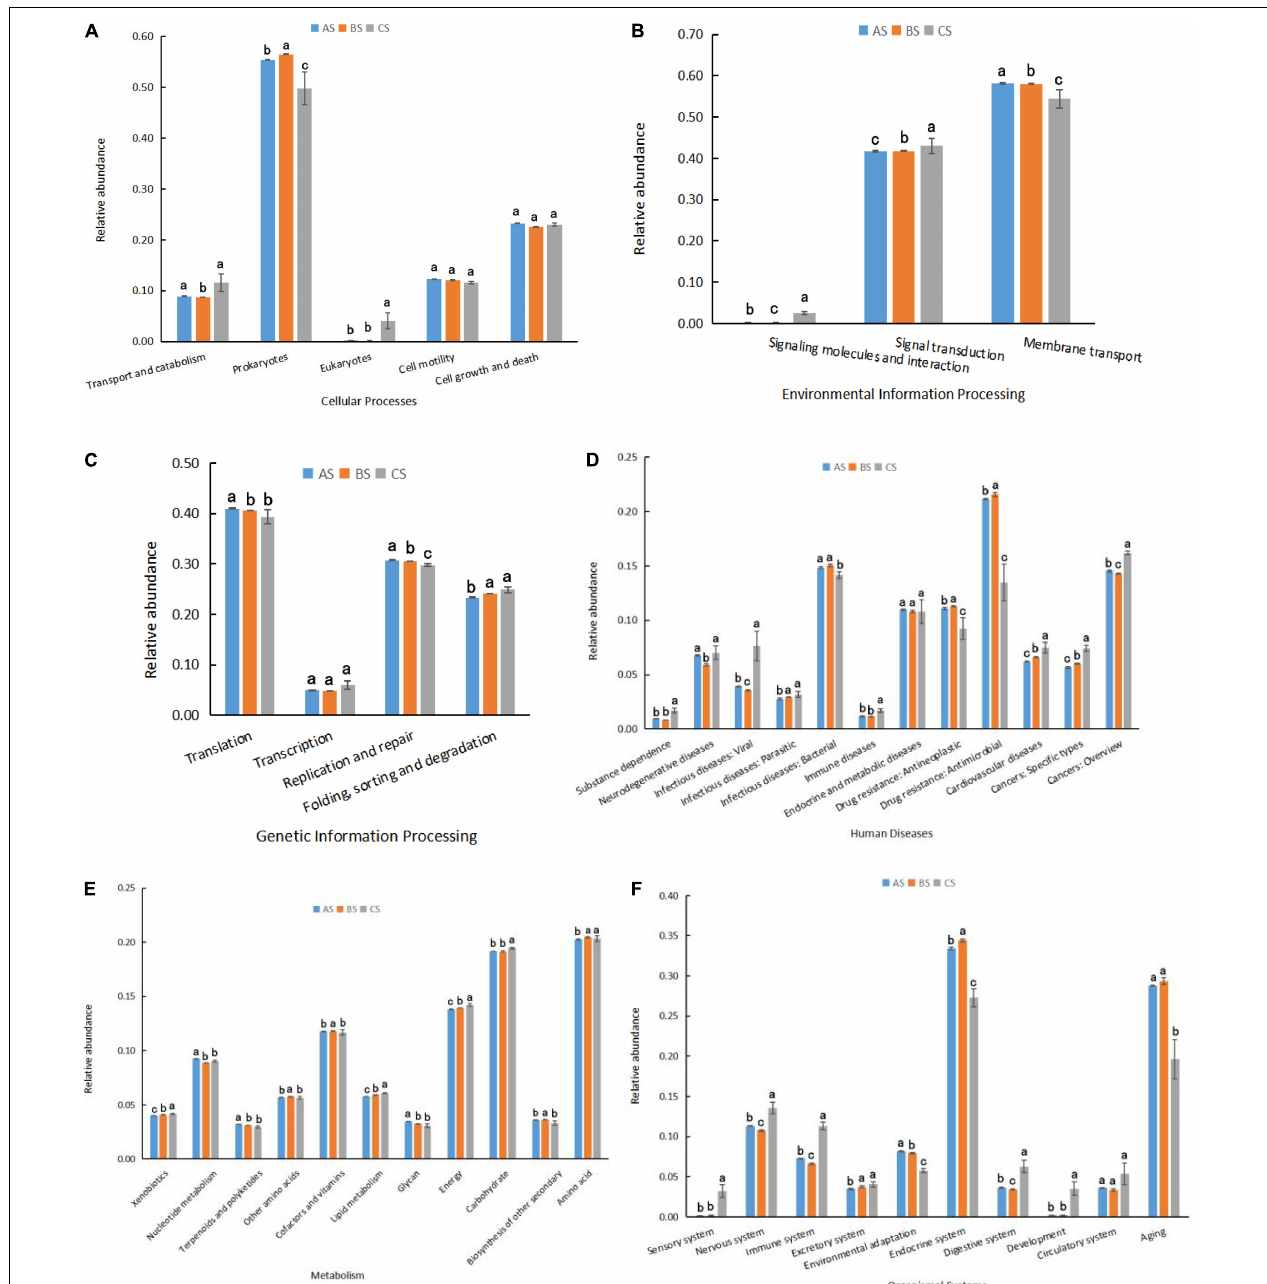
FIGURE 4 | (A–F) Predicted functional pathways for microbiotas in shrimp rearing water (AS), biofloc (BS), and intestine (CS). Means with different superscripts are significantly different ( p < 0.05) within each functional pathway. AS, water sample; BS, biofloc sample; CS, intestinal sample.